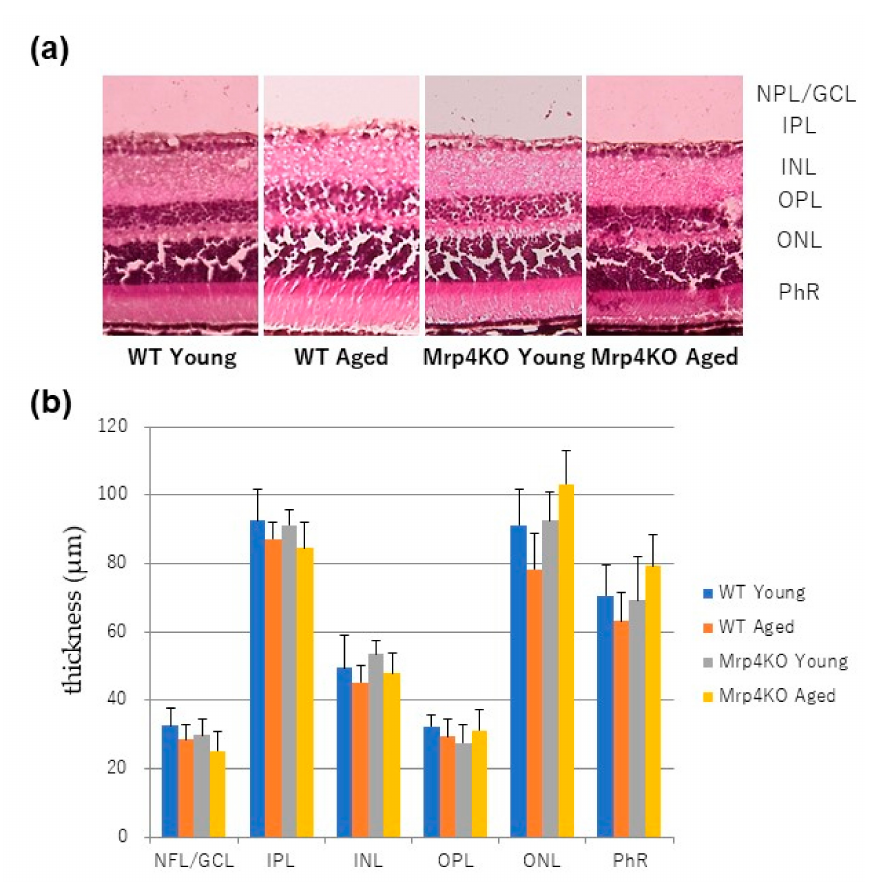
Figure 3. H&E staining results. ( a ) Representative retinal section images of H&E staining. ( b ) Quanti- tative comparison of thickness in each retinal layer. No significant difference was observed ( n = 6). WT, wild-type mice; Mrp4KO, Mrp4 -null mice; NFL, nerve fiber layer; GCL, ganglion cell layer; IPL, inner plexiform layer; INL, inner nuclear layer; OPL, outer plexiform layer; ONL, outer nuclear layer; PhR, photoreceptor layer.